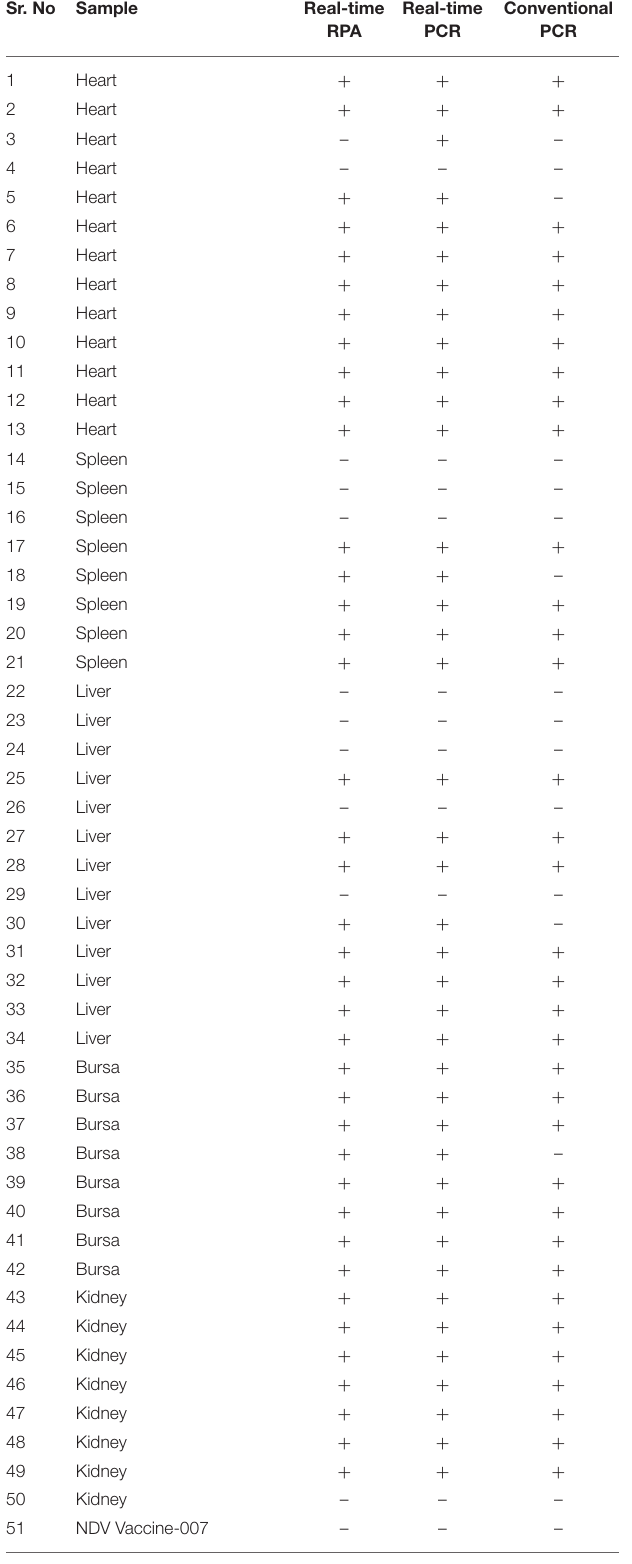
TABLE 4 | Agreement between real-time RPA detection, real-time PCR, and conventional PCR. Sr. No